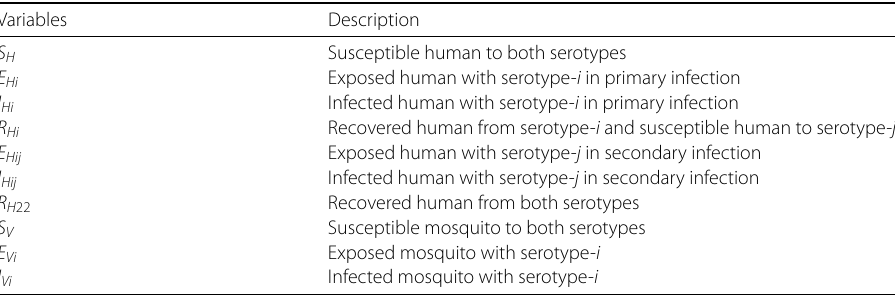
Table 1 Description of variables in model